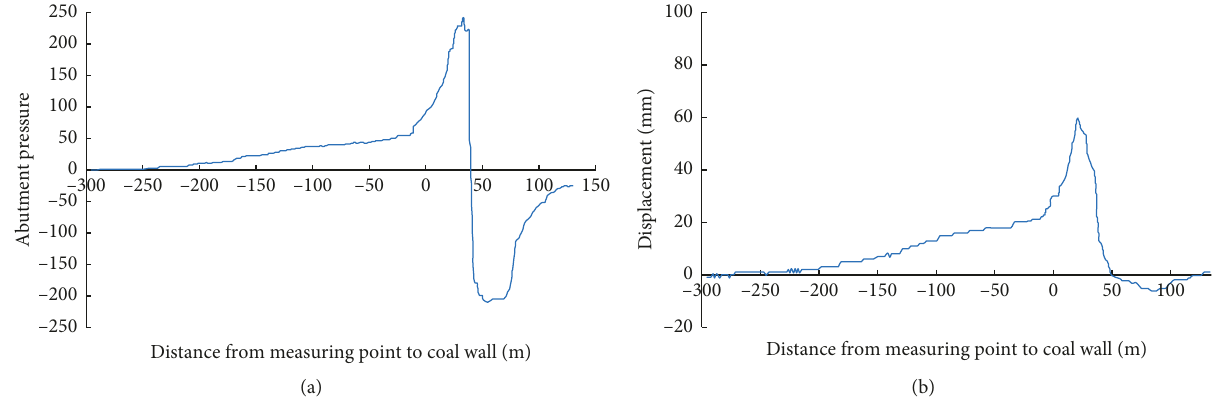
Figure 17: The changing curve of the abutment pressure in the roof as the advancement of working face at the floor strata 330 m away from the open cut (in the uphill mining section). (a) Roof (located at pressure cell 19). (b) Floor (located at pressure cell